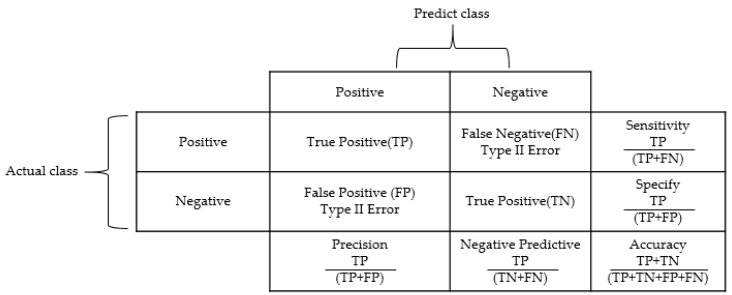
Figure 10. Artificial neural network (ANN) pattern recognition flow.